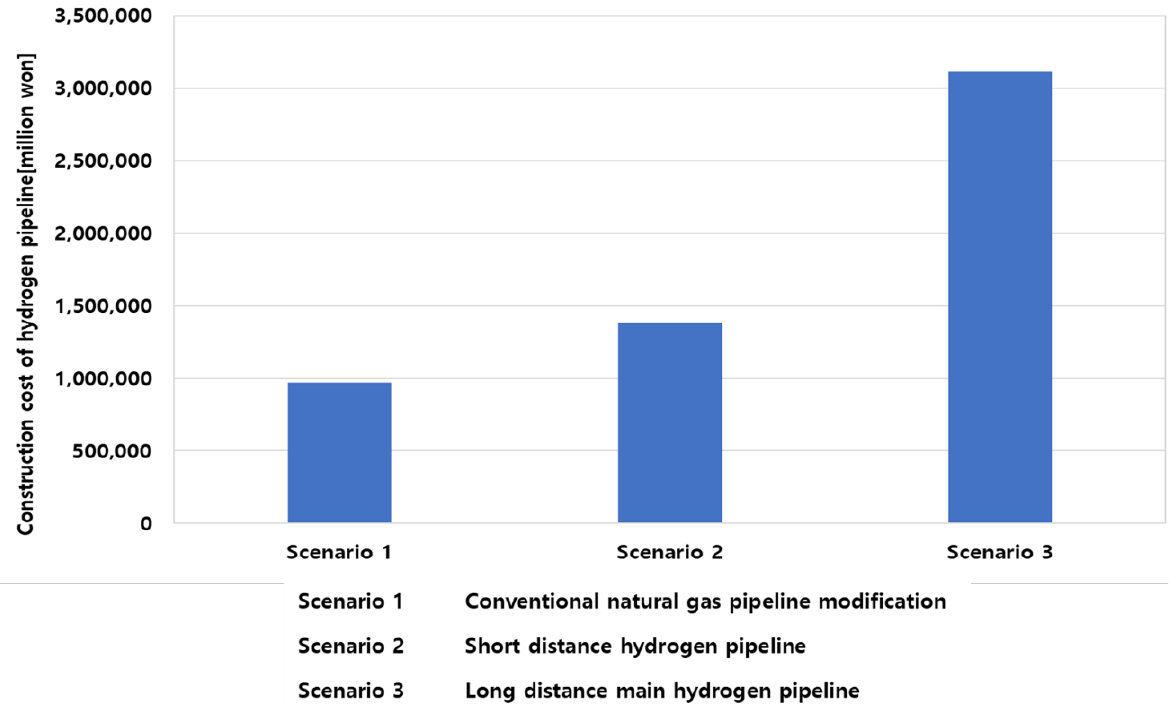
Figure 1. Construction cost of hydrogen pipelines based on case scenarios.